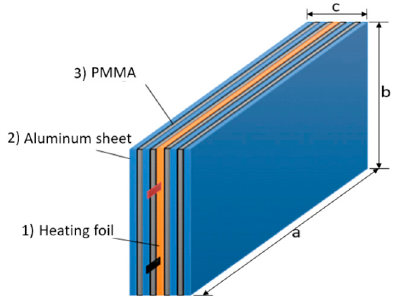
Figure 2. Geometric representation of the mimicked cell (1) Heating foil (2) Aluminum sheet (3) polymethyl methacrylate (PMMA). Table 1. Geometric size of a mimicked cell.